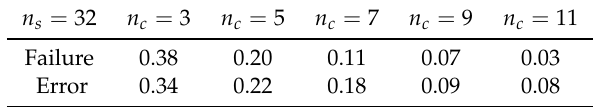
Table 5. Failure rate and error rate (32